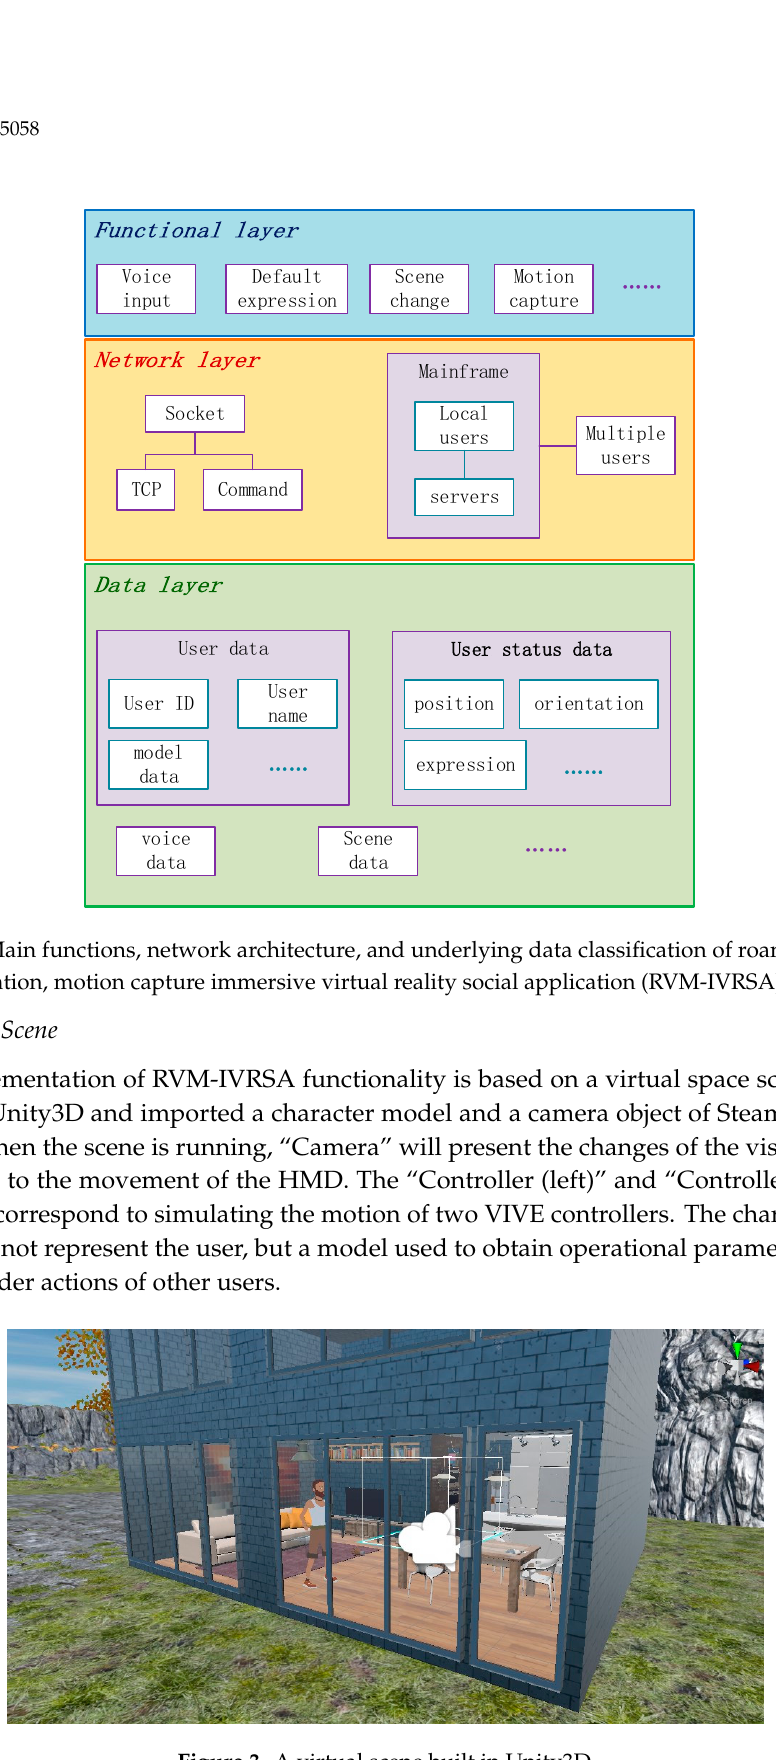
Figure 3. A virtual scene built in Unity3D.